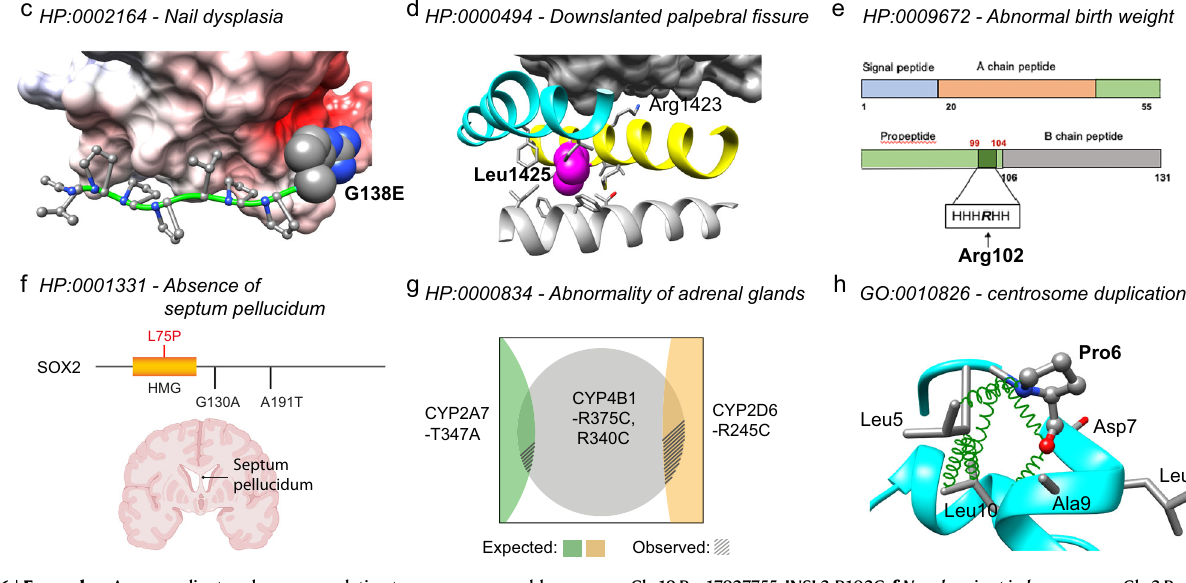
Chr19Pos17927755,INSL3-R102C. f Novelvariantinknowngene .Chr3Pos18143037, SOX2-L75P. g Combinatorialeffect .2variantsinCYP4B1-R375C/R340CandCYP2A7- T347A and CYP2D6-R245C. h Experimentally validated on HipSci . Chr3 Pos48414274, FBXW12-P6L. Panels (a) and (f) were created with